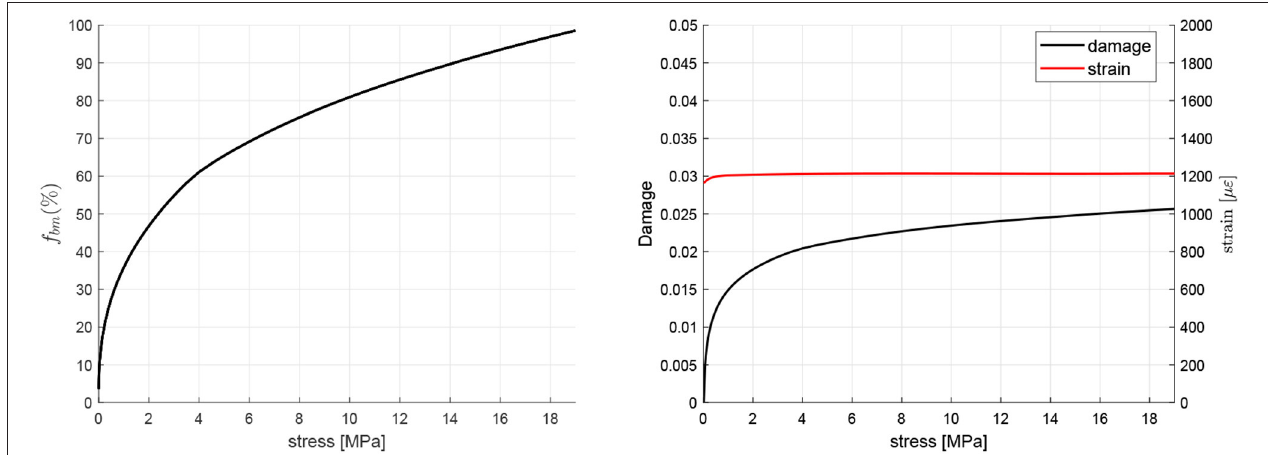
FIGURE 4 | Homeostatic values of f bm , strain and damage d for different values of uniaxial tensile